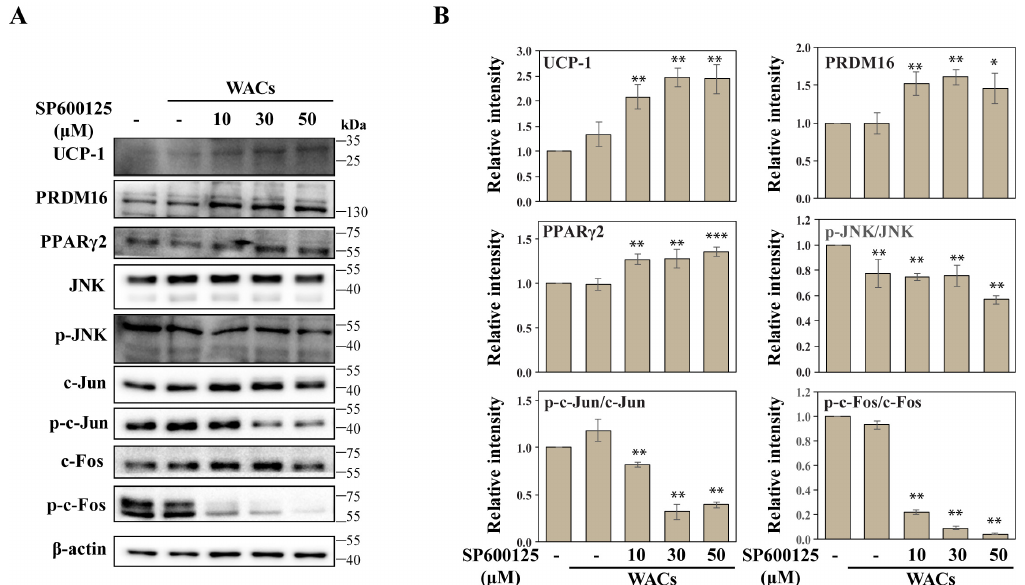
Figure 5. UCP-1 expression was upregulated by JNK inhibition. Cells were treated for 48 h with increasing concentrations (10, 30, and 50 µ M) of a JNK inhibitor (SP600125). ( A ) Validation of differentially regulated browning markers and the JNK pathway by immunoblot analysis. ( B ) The expression levels of the indicated BAC-specific proteins were quantified by Western blot analysis. The data were normalized to β -actin antibody and analyzed using ImageJ software; n = 3 independent experiments; * p < 0.05 and ** p < 0.01.